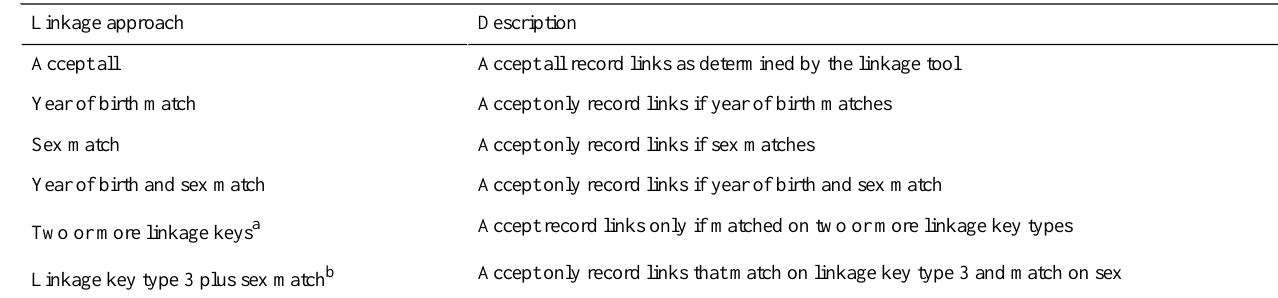
Table 1. GRHANITE Linkage Tool approaches to accepting matches.